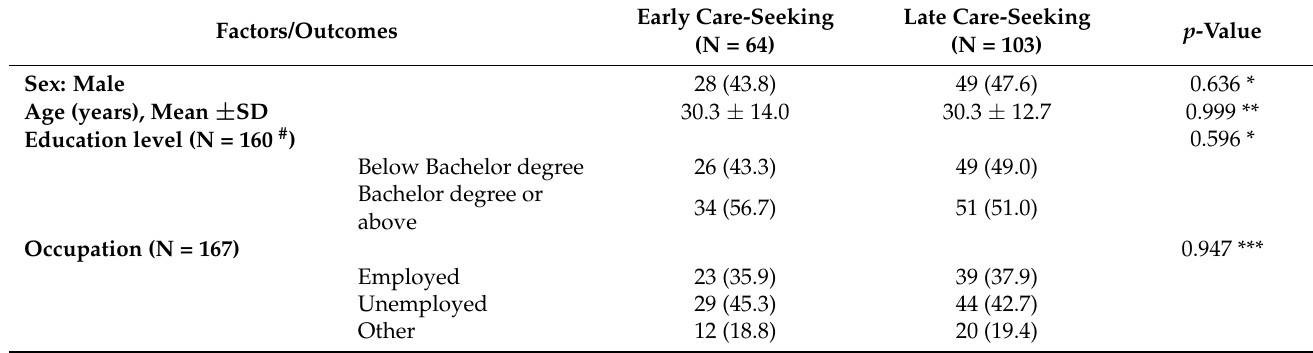
Table 2. Characteristics and clinical outcome of patients with early (1–4 days after onset) and late ( ≥ 5 days) care-seeking